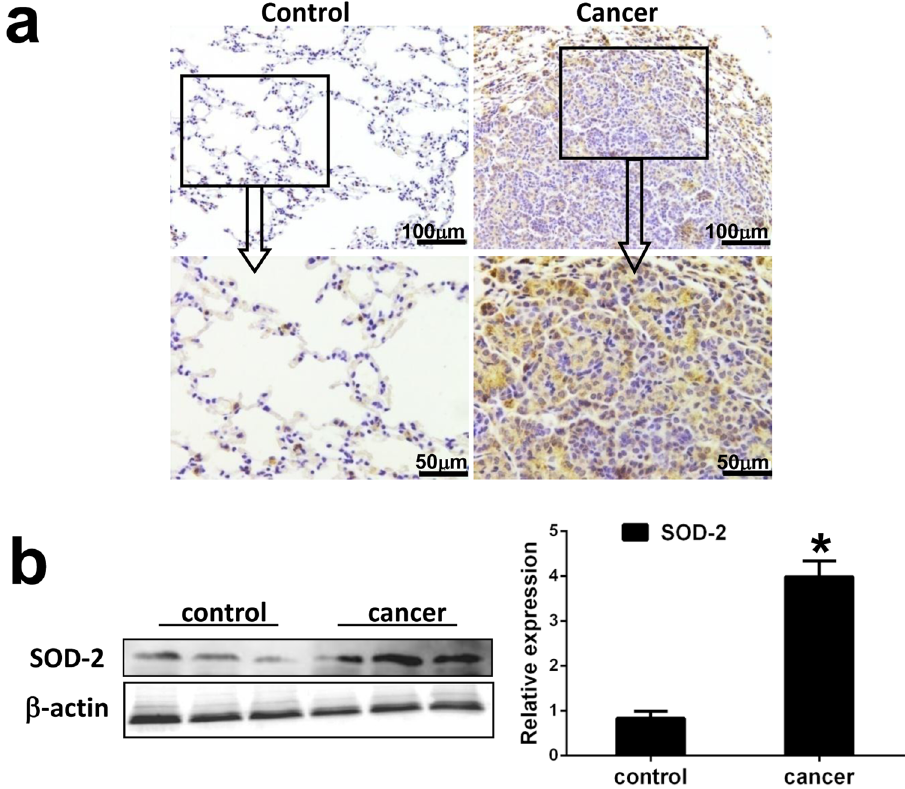
Figure 1. Enhanced SOD-2 expression is induced in AFG 1 -induced lung adenocarcinoma. ( a ) Paraffin sections of control lung tissues and AFG 1 -induced lung adenocarcinoma tissues from our previous study were prepared for immunohistochemical evaluation. Representative immunohistochemical staining of SOD-2 in AFG 1 -induced lung adenocarcinoma. ( b ) The total protein samples isolated from the lung adenocarcinoma or control lung tissues were collected from our previous study. The expression of SOD-2 at protein level from three separate control mice and AFG 1 -induced lung adenocarcinoma mice was shown by Western blot. Band intensity is coming from densitometry, and data was shown as mean ± SD (n = 3, * p < 0.05, compared to control